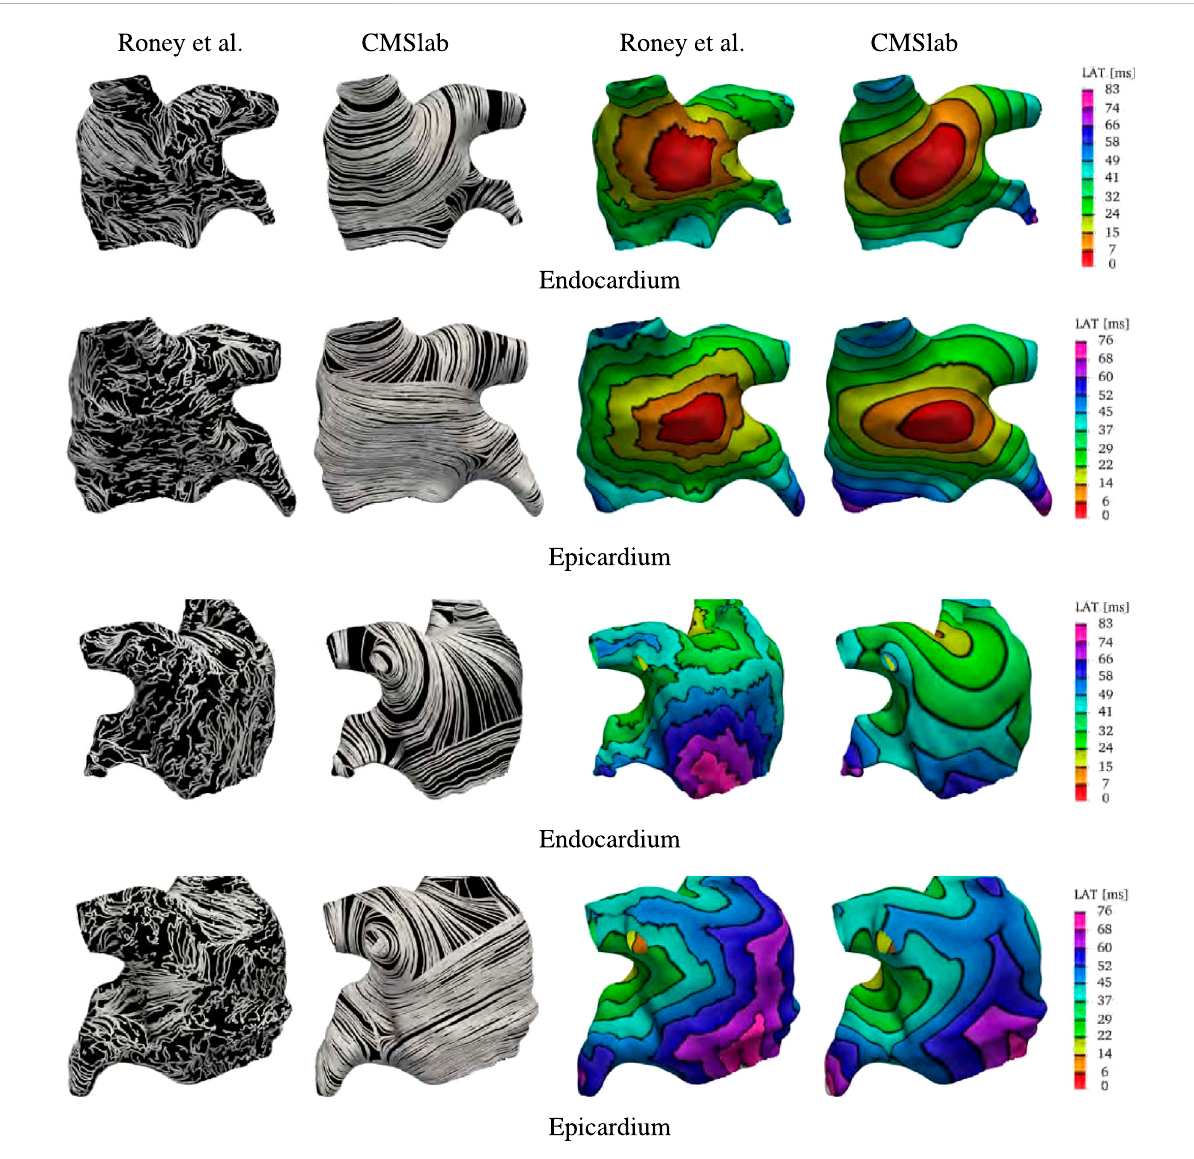
FIGURE 9 Comparison of the results obtained using the proposed fi ber construction algorithm and the atlas based method proposed by Roney et al. (2021). Using the fi rst of the geometries provided by Roney et al. (2021), we built our approximation to the fi ber fi eld based on the endocardial and epicardial surfaces. This comparison shows that the major physiological fi ber bundles can be captured by our algorithm on any given geometry in contrast to the mapping achieved using the atlas-based method. The resulting fi bers generates different activation times, especially on the endocardial surface. Note that the smoothness of the fi ber fi eld is re fl ected in the fi nal activation